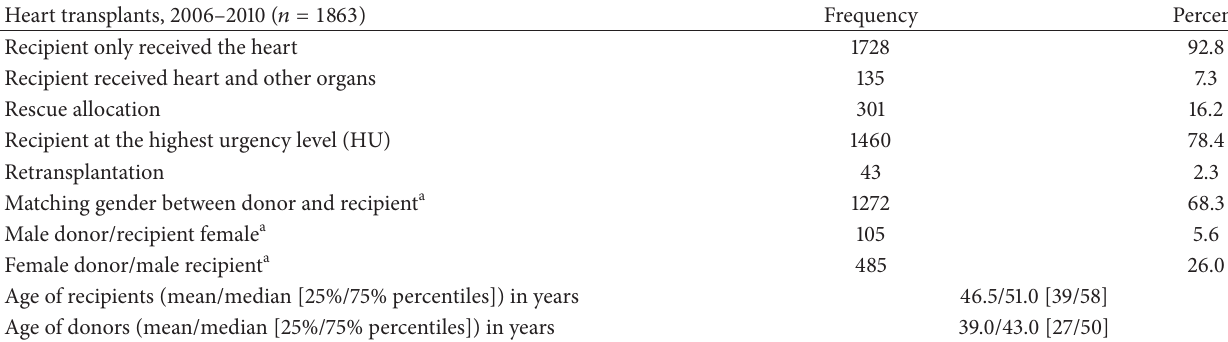
Table 1: Characteristics of heart transplants in Germany 2006–2010 (German donors only).